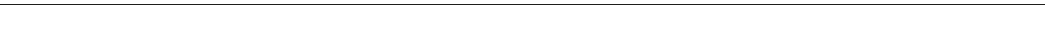
Fig. 4 Steroid hormone receptor binding differs between male breast cancer subtypes. a Unsupervised hierarchical clustering of RNA-seq of 46 male breast tumors, using the M1/M2 classi fi er genes de fi ned by Johansson et al. 4 Standardized gene expression value is denoted as the row Z -score and plotted in high expression (blue) and low expression (yellow) scale. Top row indicates M1 (red) or M2 (blue) classi fi cation. b Correlation plots of signi fi cantly differentially bound regions for ER α between 24 M1 (red) and 3 M2 (blue) tumors. Pearson correlation is depicted from 0 (white) to 1 (dark green) for all panels. c Heatmaps for all factors with known M1/M2 subtype classi fi cation, depicting raw signal intensities at differential bound ER α sites between M1 and M2. d Genomic distribution for differentially ER α -bound sites by M1 and M2 subtypes. e Bar plots indicating top 5 sequence motifs enriched in M1 and M2 differentially ER α -bound sites. f Ingenuity Pathway Analysis of Upstream Regulators and their p -values identi fi ed in both ER α binding site associated